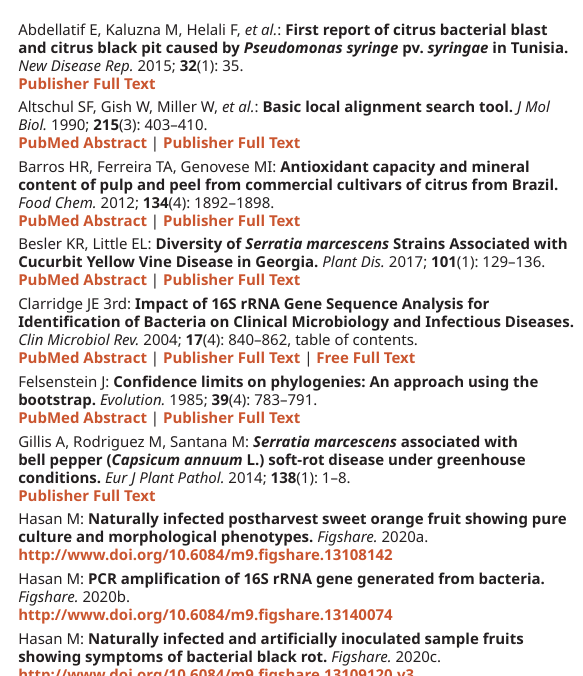
Figshare: Antagonistic activity of soil born bacteria against the isolates BS1,